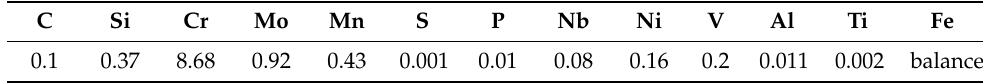
Table 1. Chemical composition of experimental P91 steel